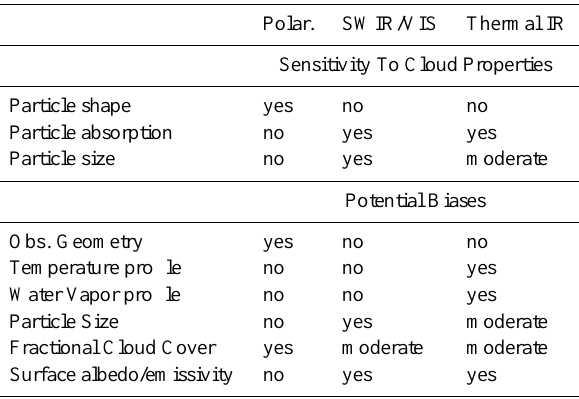
Table 1. Summary of phase algorithm capabilities and limitation.